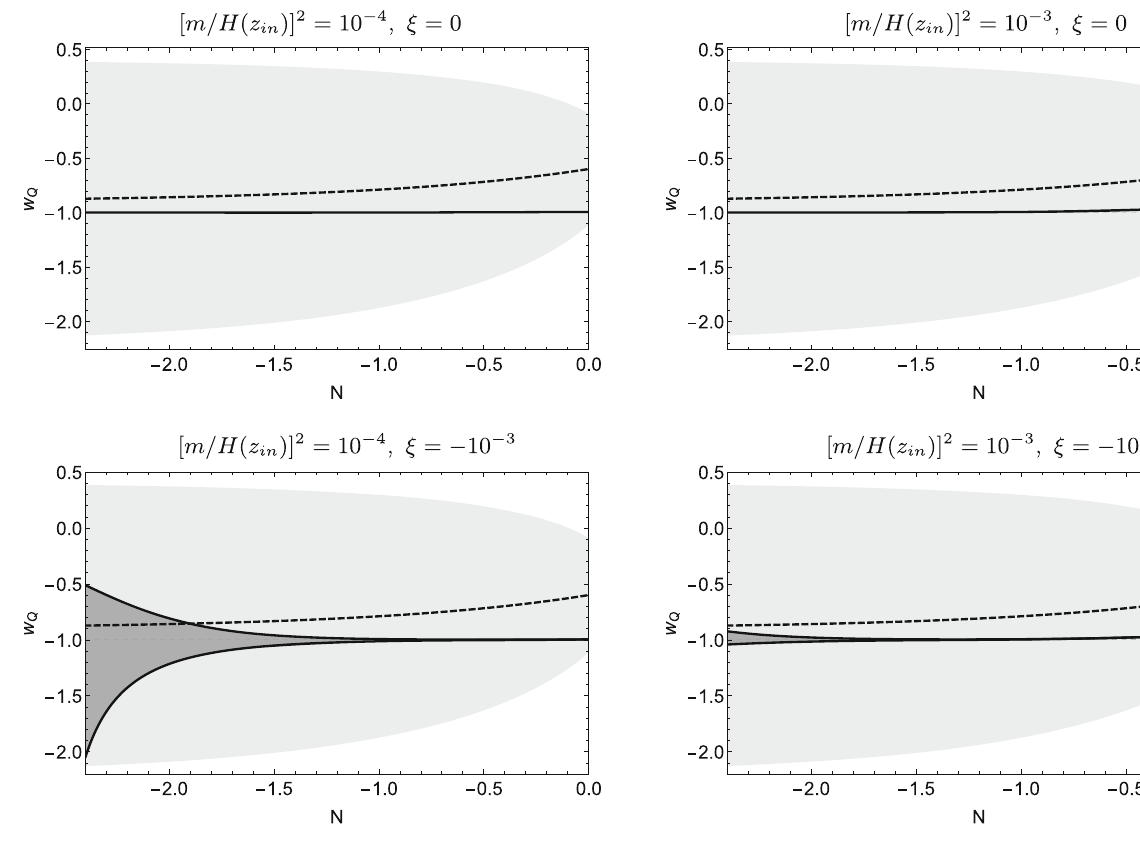
in the w 0 w a CDM model, in which w DE ( N ) = w 0 + ( 1 − e N )w a , and the shaded region is the 1 σ contour corresponding to w 0 =− 0 . 6 ± 0 . 25, w =− 0 . 3 ± 0 . a